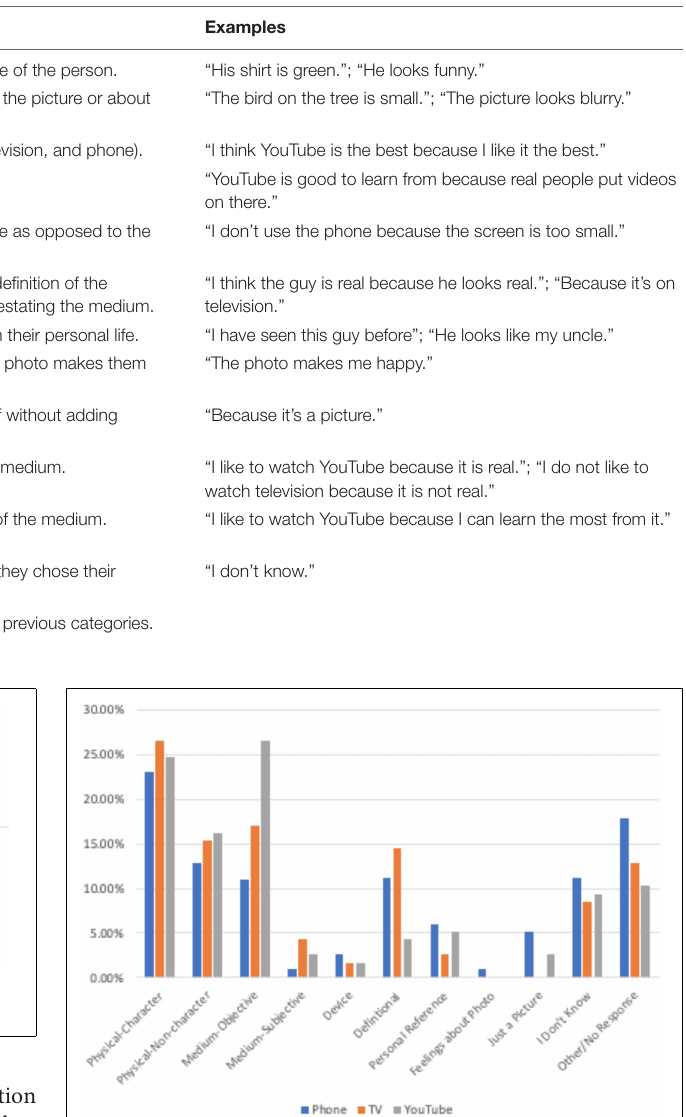
The age group by medium interaction was not significant, suggesting that the differences by medium were consistent across the age